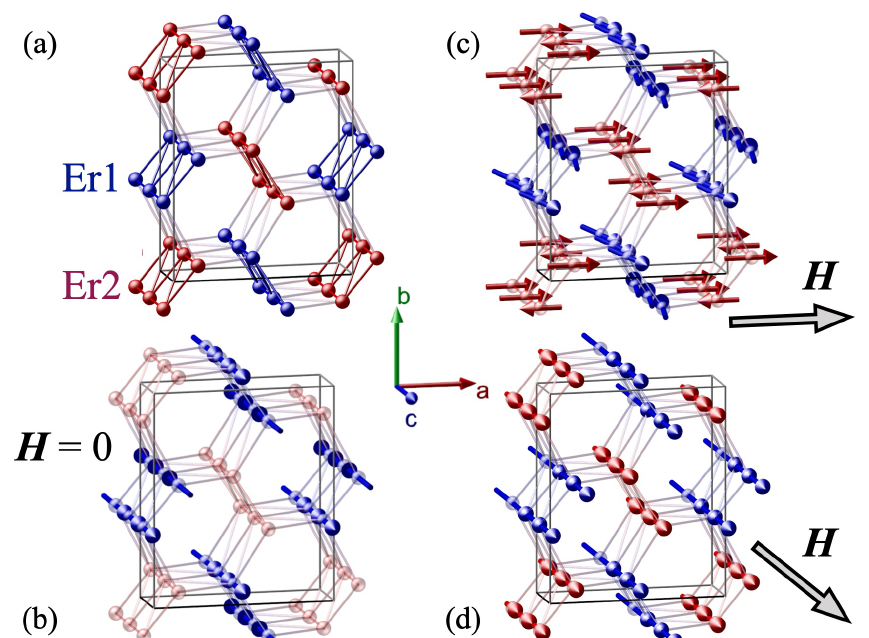
Figure 1: (a) Geometry of the zigzag ladders formed by the Er1 (blue) and Er2 (red) magnetic ions in SrEr O . (b) Long-range antiferromagnetic structure formed by the 2 4 Er1 ions in zero field where the Er2 ions remain largely disordered (although they do participate in a formation of weakly correlated spin-chains). (c) Field induced UUD order of the Er2 ions emerging in almost undistorted zero-field structure of the Er1 ions for the field between 4 and 12 kOe applied along the a axis. (d) Field polarised structure for H (cid:107) c in which both Er1 and Er2 ions carry significant but still different magnetic